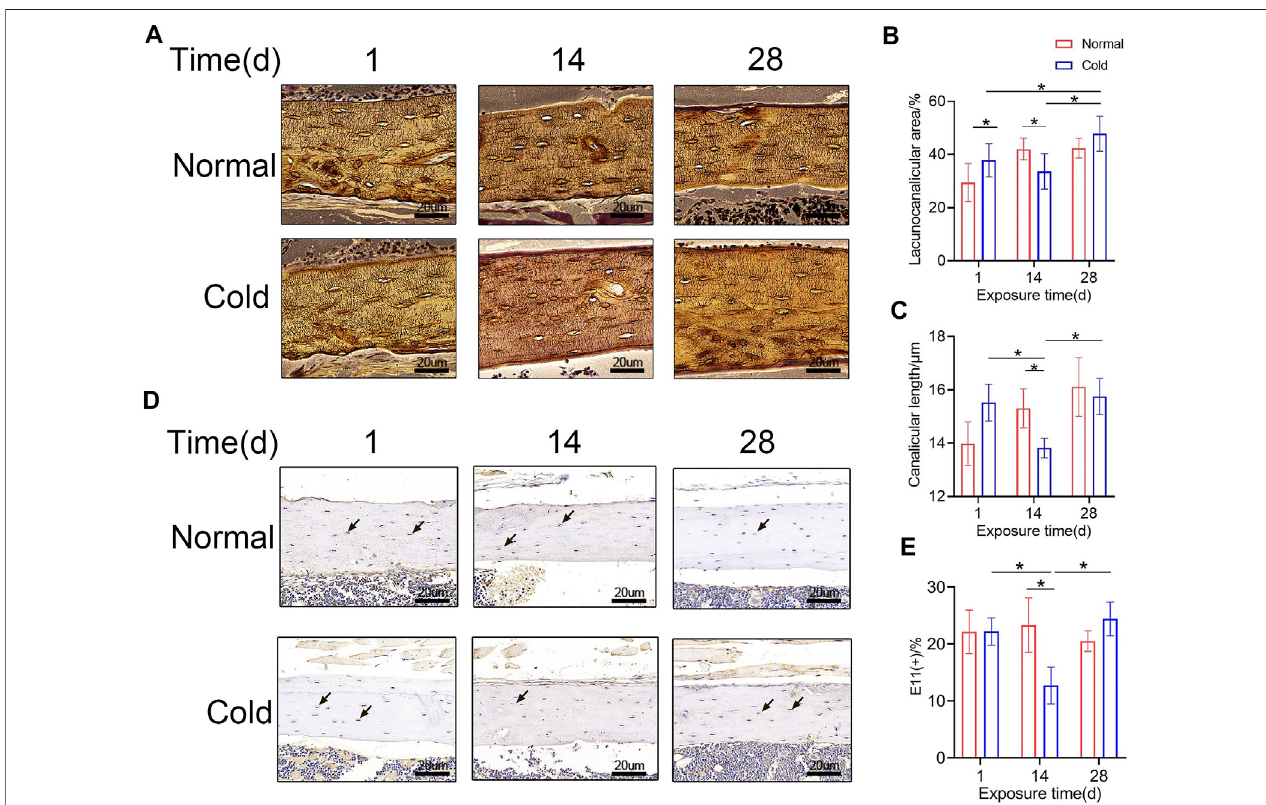
FIGURE 2 | Osteocyte canaliculus shows alterations with exposure to cold temperature. (A) Ploton silver stain was performed to show the canalicular network in corticalbone. (B – C) Lacuno-canalicularareaandcanalicularlengthweremeasuredandthedifferencesamongthegroupsareshown. (D) Immunohistochemicalstainof E11 in the femurs was performed. (E) E11-positive osteocytes are calculated and statistic results are shown. Black arrows: E11 positive osteocytes. Data are shown as mean ± SD ( n (cid:2) 5 per group). Signi fi cance ( p value) is calculated using two-way ANOVA, * p < 0.05.